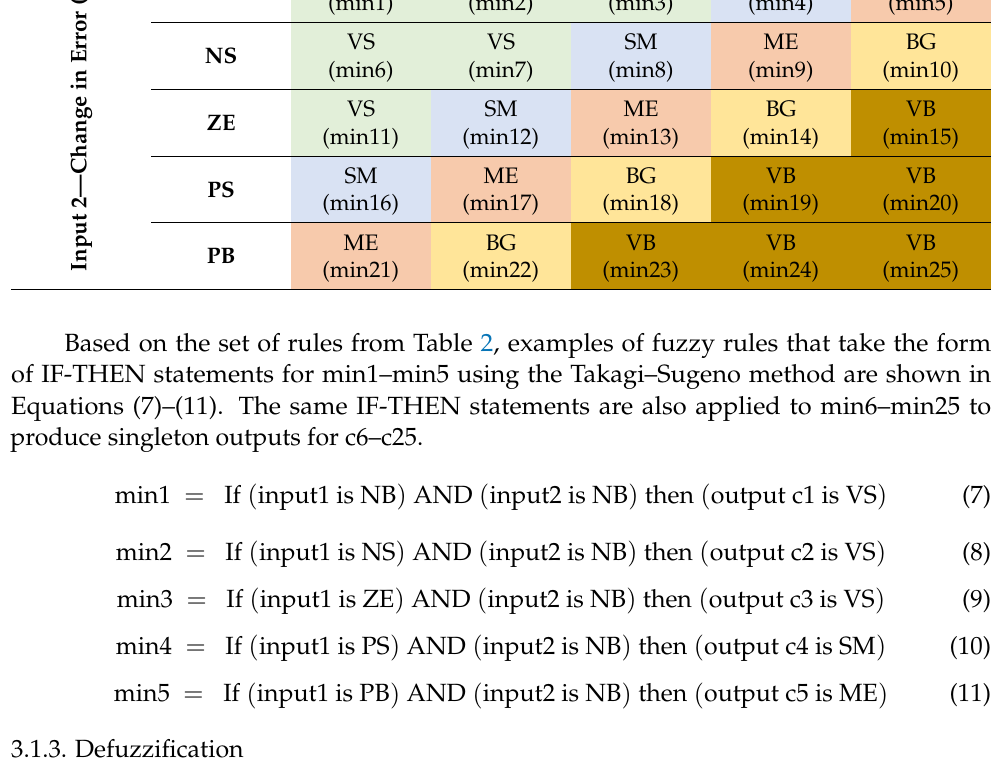
Small (PS) and Positive Big (PB). The singleton output MFs are Very Small (VS), Small (SM), Medium